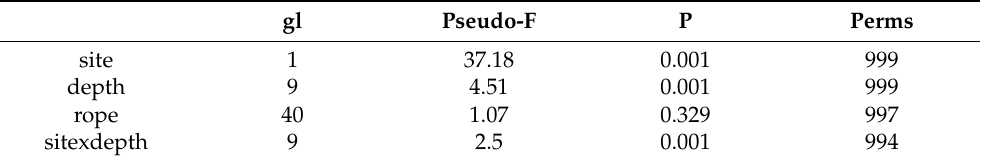
Table 3. PERMANOVA test on Bray–Curtis similarities of square root-transformed data according to site (2 levels, fixed: Pellestrina and Caleri), depth (10 levels from 5 to 14 m, fixed) and rope (random). gl Pseudo-F P Perms site 1 37.18 0.001 999 depth 9 4.51 0.001 999 rope 40 1.07 0.329 997 sitexdepth 9 2.5 0.001